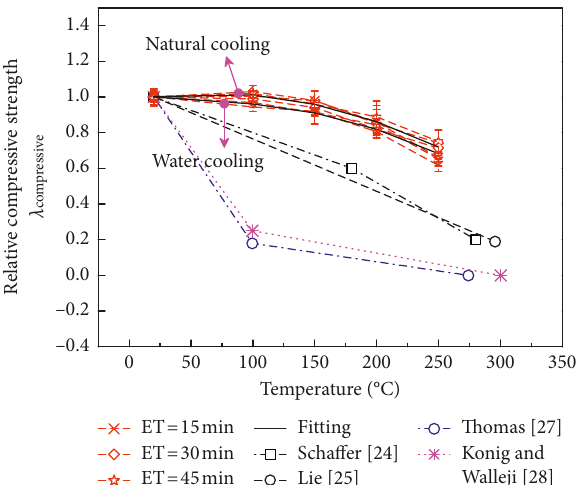
Figure 9: Relative compressive strength of wood parallel to grain as a function of exposure temperature (ET